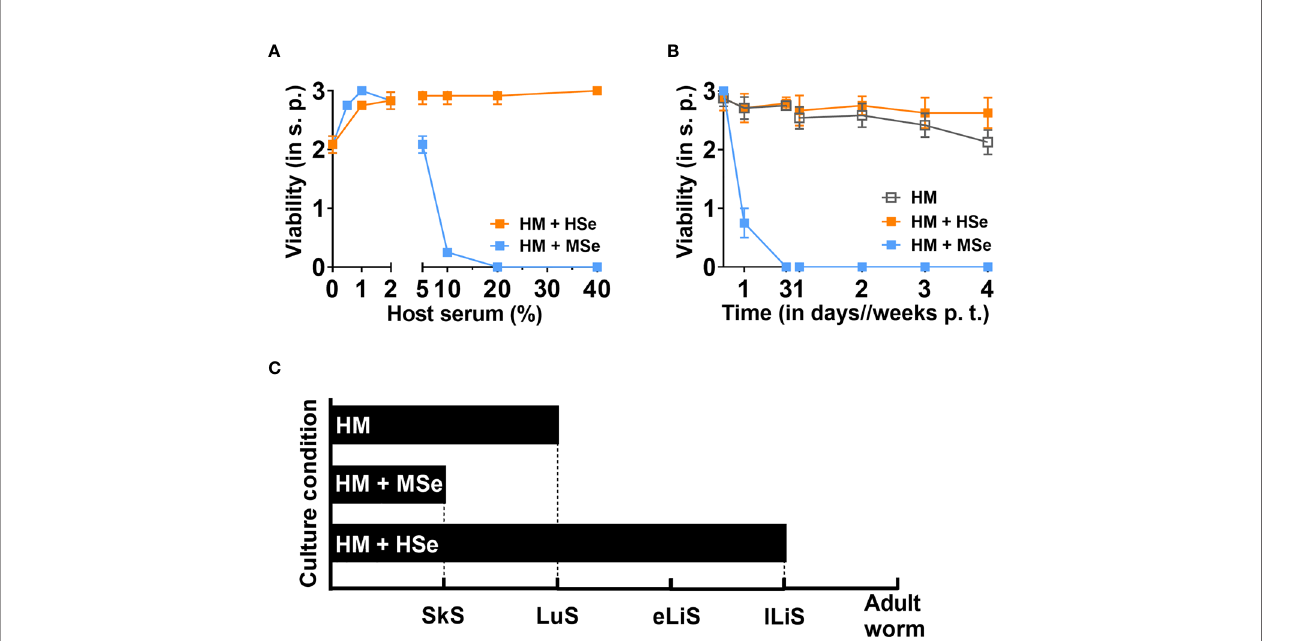
FIGURE 1 | Mouse serum rapidly kills NTS whereas human serum promotes their development and survival. NTS were cultured and maintained in hybridoma medium (HM) with or without host sera at 37°C in 5% CO 2 for four weeks. Medium was refreshed weekly. (A) Mouse serum (MSe) kills NTS in a concentration- dependent manner. NTS were cultured in the absence or presence of increasing concentrations of human serum (HSe) or MSe and the viability scored at day seven. (B) MSe kills NTS rapidly. NTS were cultured in HM in the absence or presence of 20% of HSe or MSe and viability scored at indicated time points. Results are representative of at least three individual experiments. Each data point has been shown as mean ± SD of at least three technical replicates. (C) Schematic presentation of development of schistosomula. NTS were cultured in HM in the presence or absence of HSe or MSe in the same manner and monitored as above and the development assessed. SkS, skin stage; LuS, lung stage; eLiS, early liver stage; lLiS, late liver stage; p.t., post transformation; s.p., scoring